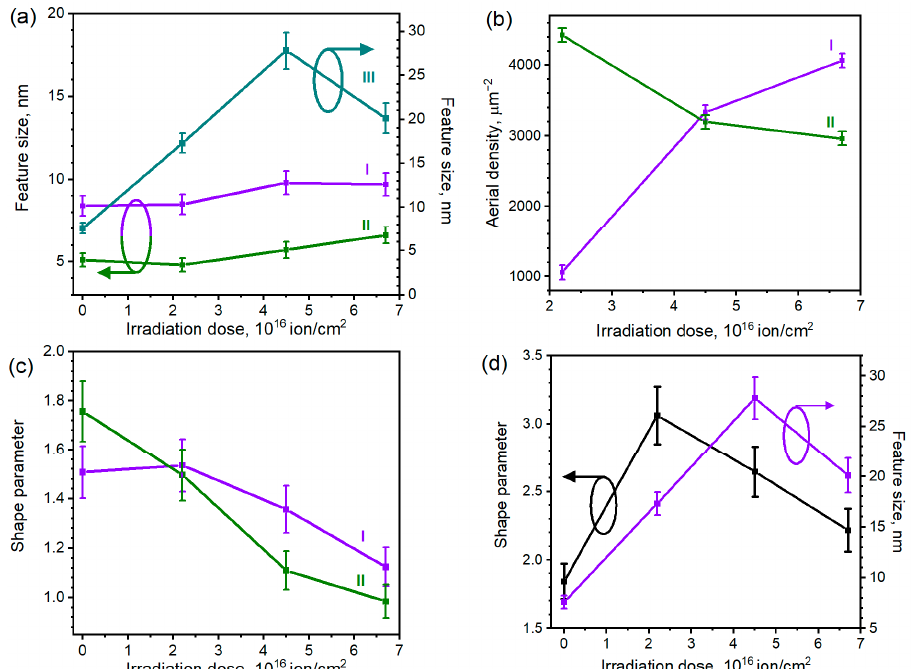
Figure 6. ( a ) Average size of the particles and convexes of the samples irradiated with various ion doses. ( b ) The dependence of average aerial density on the ion irradiation dose for irradiated sets I and II. ( c ) The dependence of the shape parameter of the nanoparticles on the ion irradiation dose for sets I and II. ( d ) The dependence of the shape parameter and sizes of characteristic morphological features on the ion irradiation dose for set III.